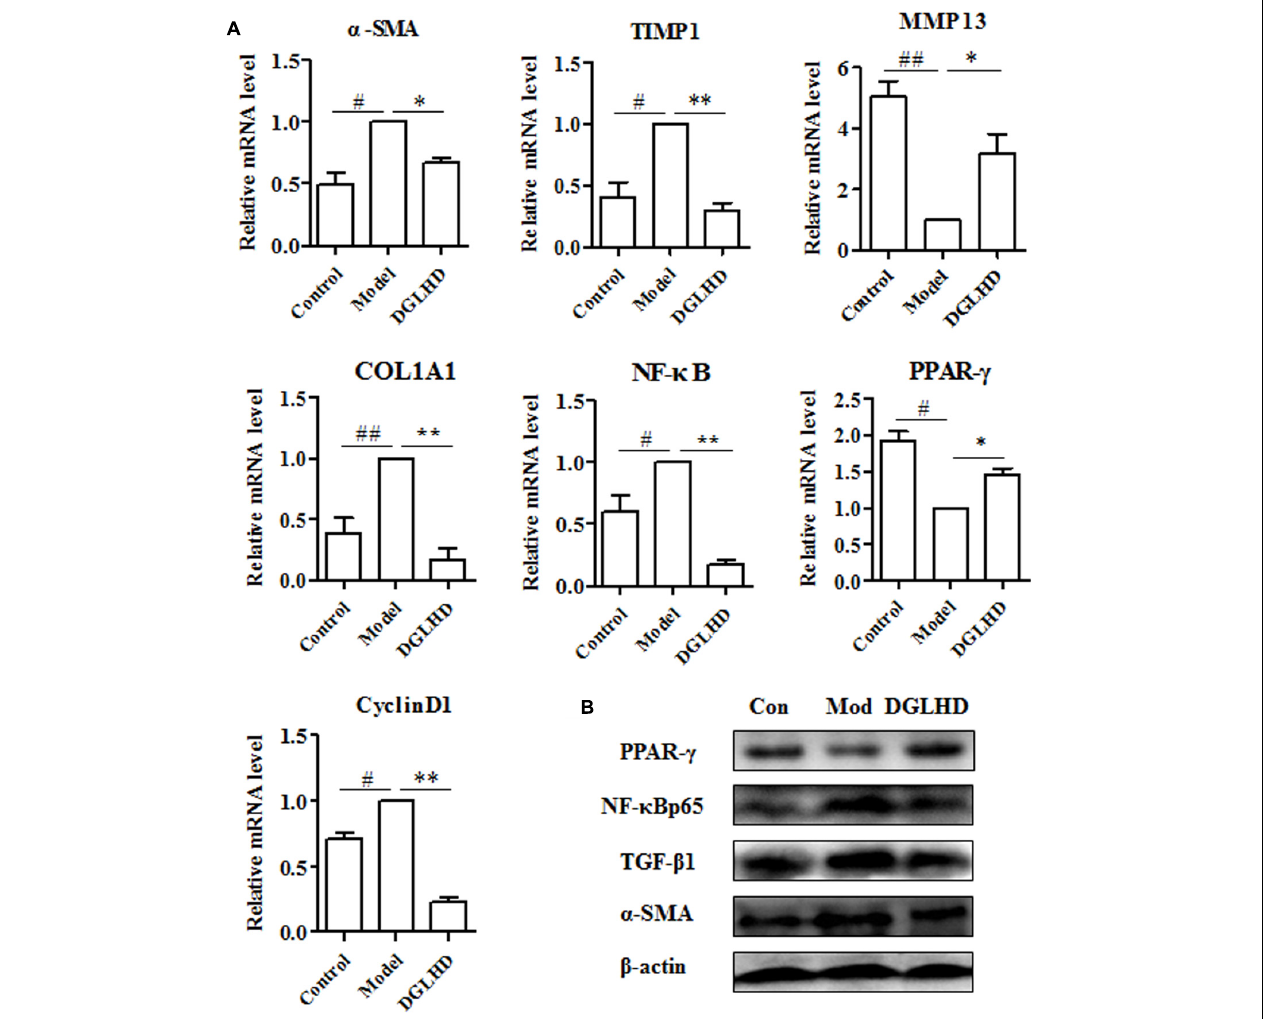
FIGURE 6 | Dangguiliuhuang decoction suppressed ECM accumulation in liver. Hepatic tissues were isolated from normal mice and fibrotic mice treated with water or DGLHD (5.0 g/kg). (A) Fold change of gene expression was detected by qRT-PCR analyses. (B) Protein expressions of TGF- β 1, α -SMA, PPAR- γ , NF- κ B were determined by Western blotting. Proteins and genes were normalized to Model. β -actin was used as the internal reference. Data are presented as mean ± SEM ( n = 4). # P < 0.05, ## P < 0.01 compared to Control. ∗ P < 0.05, ∗∗ P < 0.01 compared to